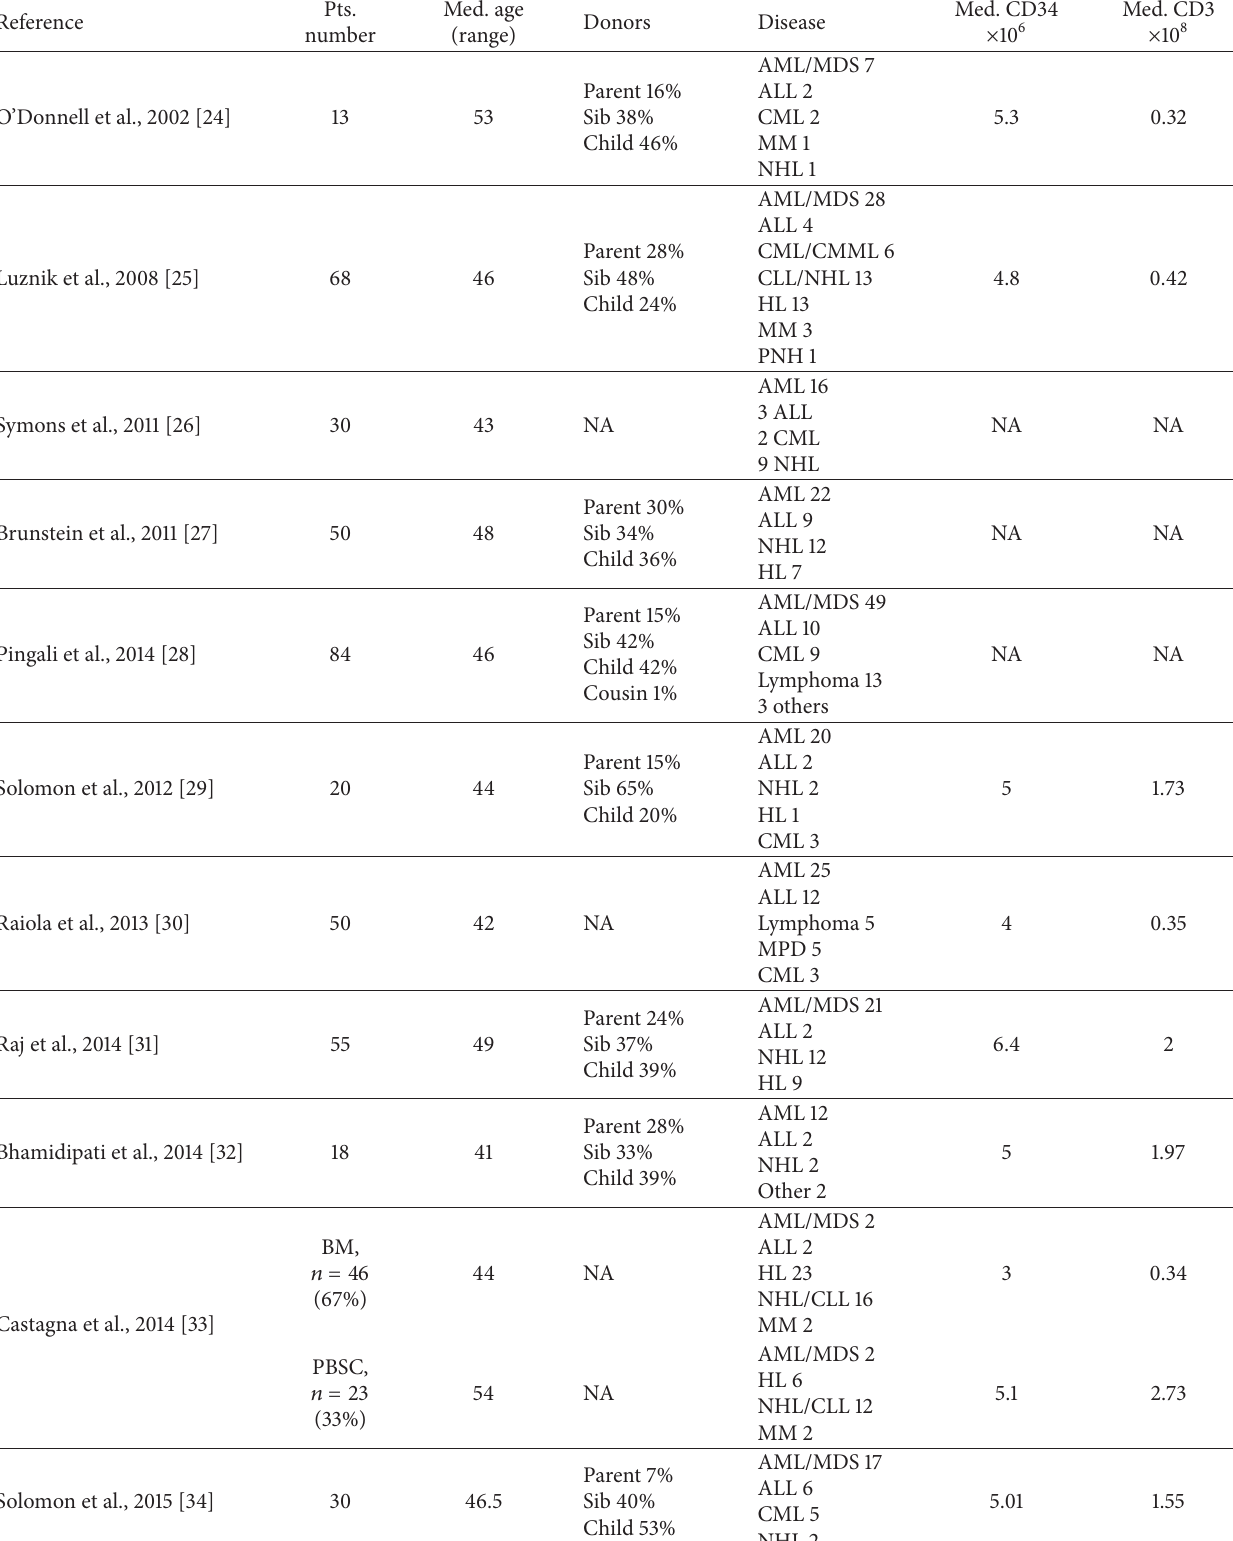
Table 2: Patients, donors, and graft